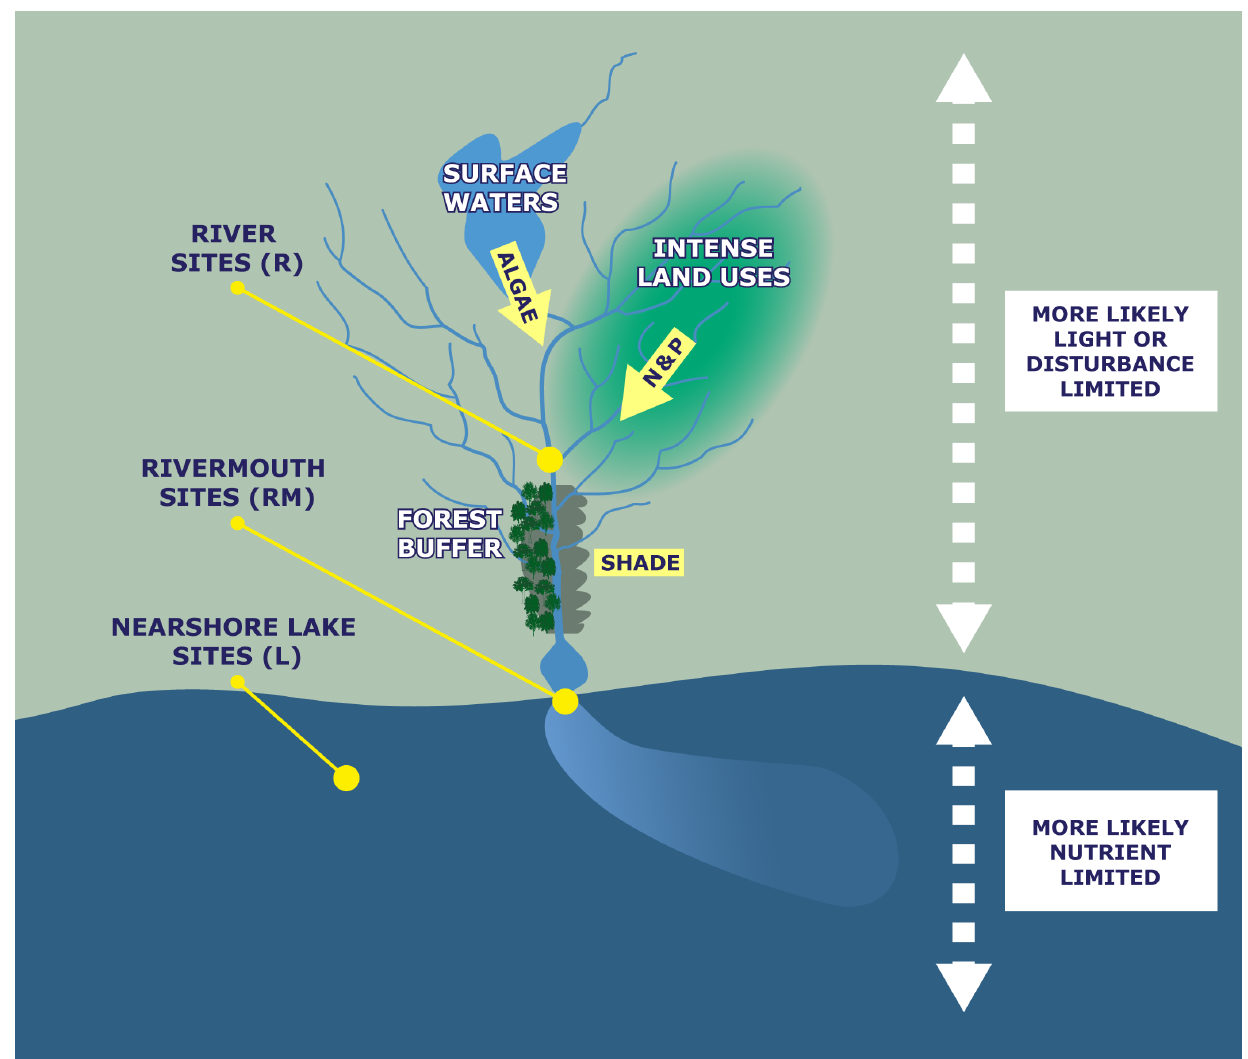
Figure 1. Conceptual figure showing predictions and study design in the context of a hypothetical tributary system. Our underlying prediction is that watershed land cover significantly influences fatty acid (FA) content of seston and consumers via effects on algal production and composition. The land cover properties investigated here are highlighted in white font (surface waters, intense land uses, and forest buffers) with their presumed mechanistic relationship to algal dynamics in yellow boxes or arrows (algal export, nitrogen [N] and phosphorus [P] loading and stream shading). Habitat types sampled in this study are also shown (river, rivermouth and nearshore lake sites).